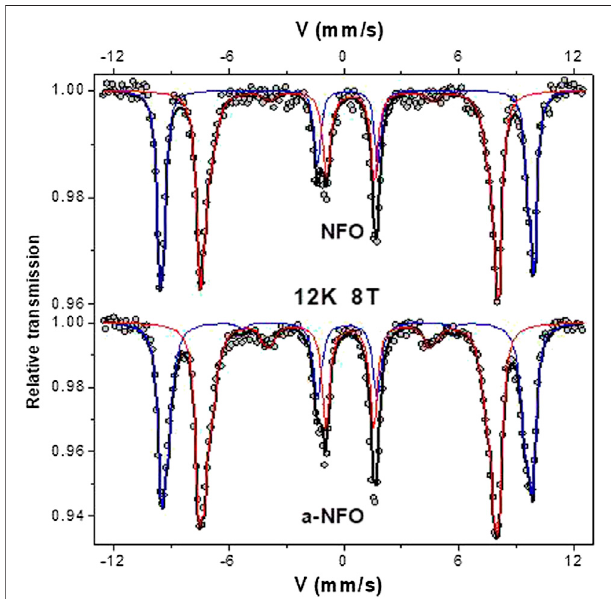
FIGURE 5 | 12 K in 8T fi eld Mössbauer spectra of NFO and a-NFO. The scatterscorrespondtotheexperimentaldata.Thecontinuedlinescorrespond to the calculated ones for octahedral (blue) and tetrahedral (red) coordinated ferric contributions.